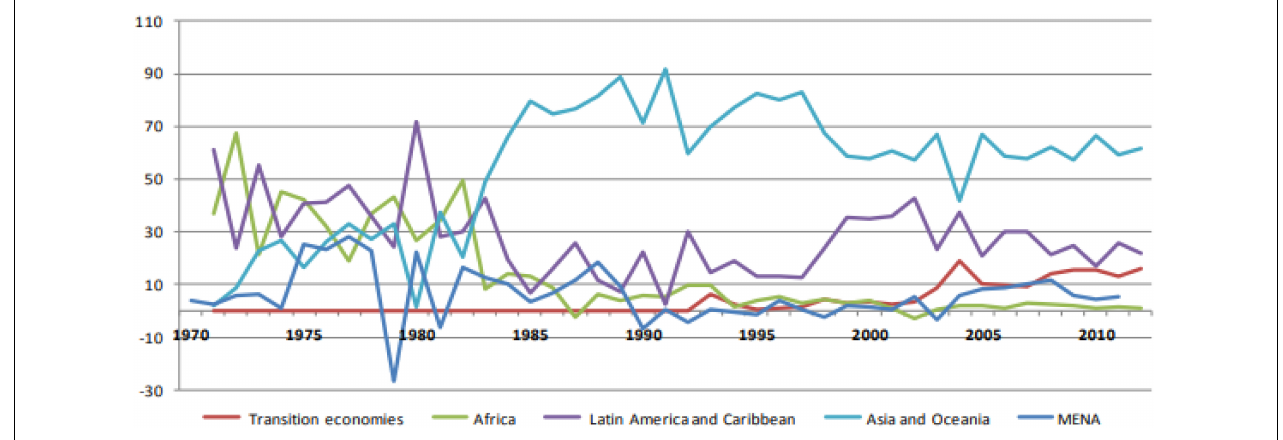
FIGURE 2 | Trend of Rise of FDIO in Asia, Africa, and Latin America (UNCTAD,